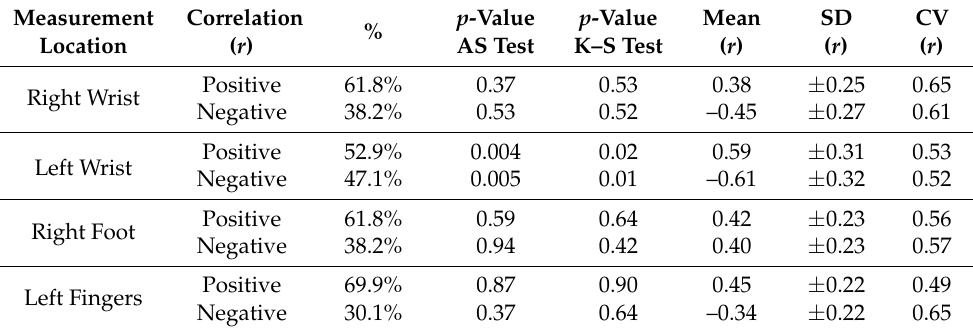
Table 4. Statistics of the correlation matrices of each GSR